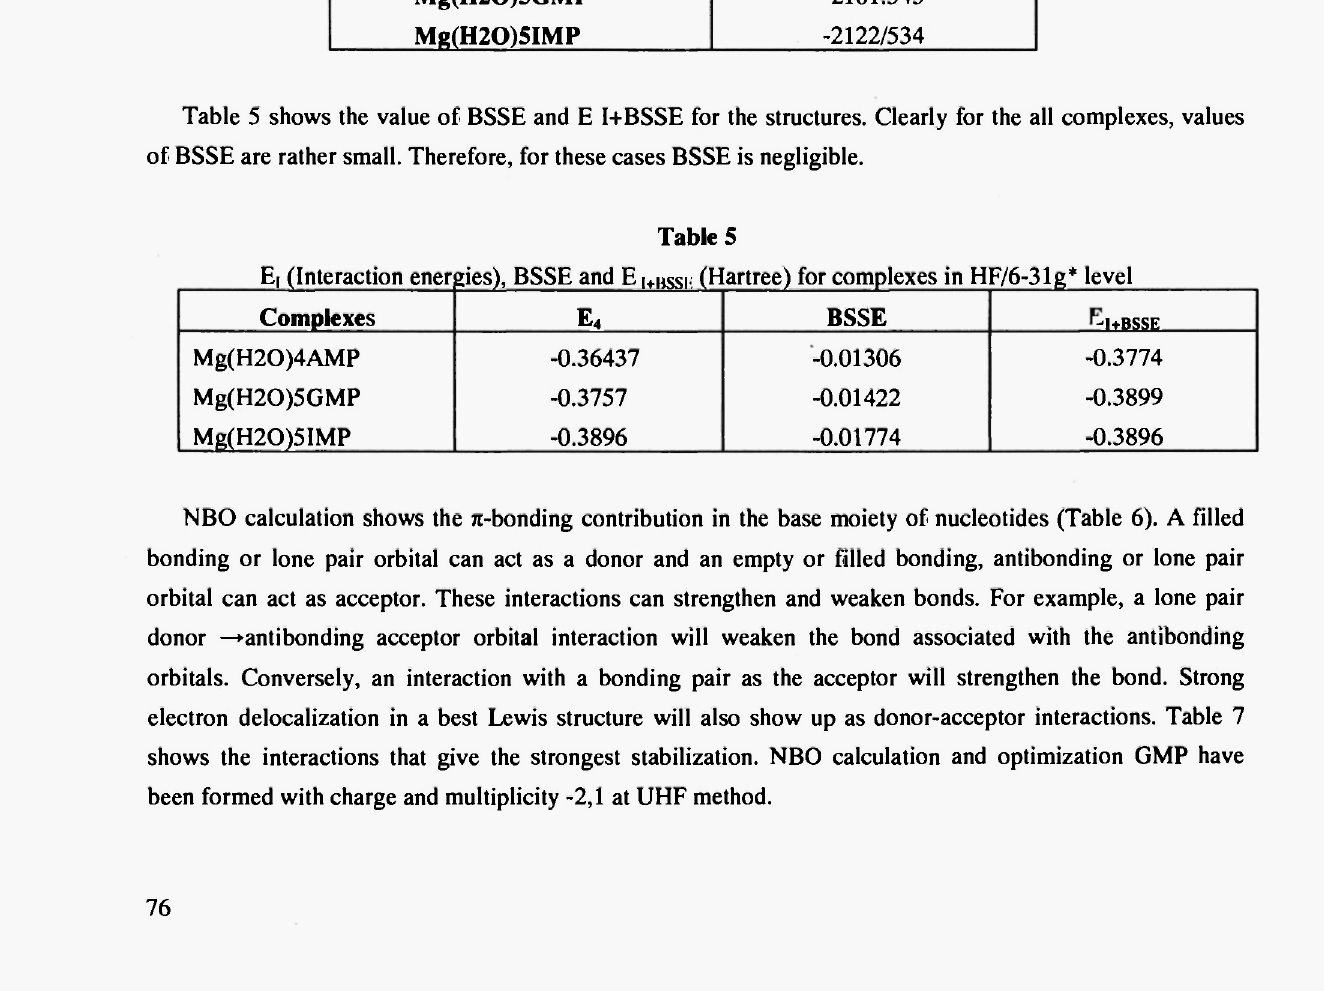
E| (Interaction energies), BSSE and Ε I+BSSI : (Hartree) for complexes in HF/6-31g*